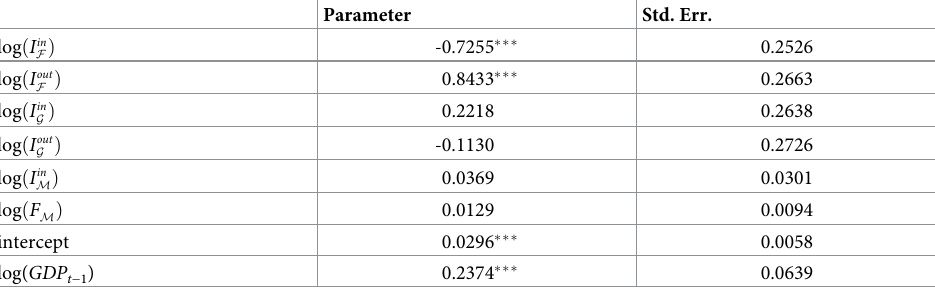
Table 3. Results for the Arellano-Bond estimates of model 10. p-value notation is ��� , �� and � for significance at the 1%, 5% and 10% levels respectively. Adjusted R 2 = 0.102, and F − stat = 35.671. We observe that the social capital effects maintain the same signs and similar magnitudes as in the random effects estimates (in Table 2), however some of the effects loose their statistical significance.